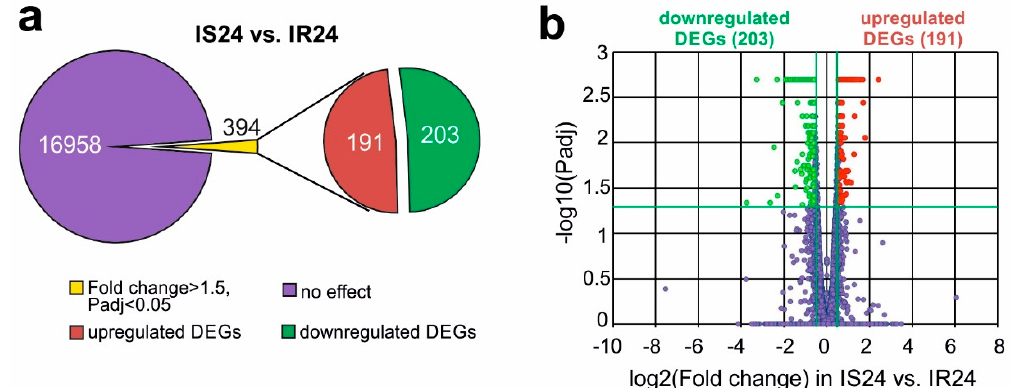
Figure 2. RNA-Seq analysis of the effect of Semax on the transcriptome at 24 h after tMCAO. ( a ) RNA-Seq results presented are for in IS24 versus IR24. The numbers in the diagram sectors indicate the number of DEGs. ( b ) Volcano plots show the distributions of genes between the IS24 and IR24 groups. Up- and downregulated DEGs are represented as red and green dots, respectively (fold change > 1.50. Padj < 0.05). Not differential expressed genes are represented as dark purple dots (fold change ≤ 1.50. Padj ≥ 0.05).